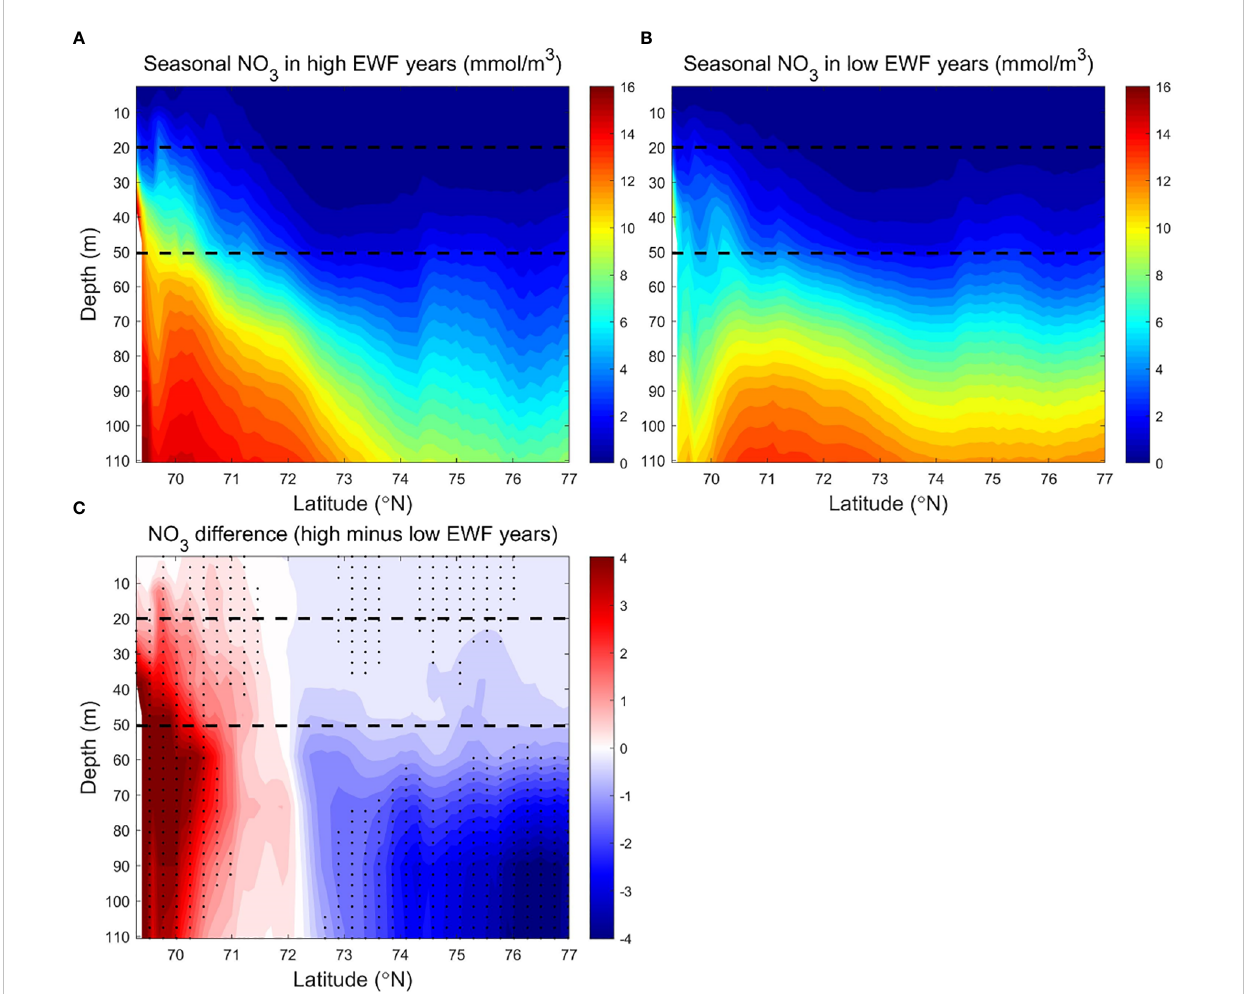
FIGURE 10 Modeled seasonally (June to September) averaged NO 3 (mmol/m 3 ) in the BC in (A) high (1998, 2007, 2008, 2010, 2011) and (B) low (1991, 1992, 1994, 1996, 2002) EWF yeas, and (C) their differences (high minus low). The dashed lines denote 20 m and 50 m depth separately. In Figure 10C, black dots denote where p <0.05.